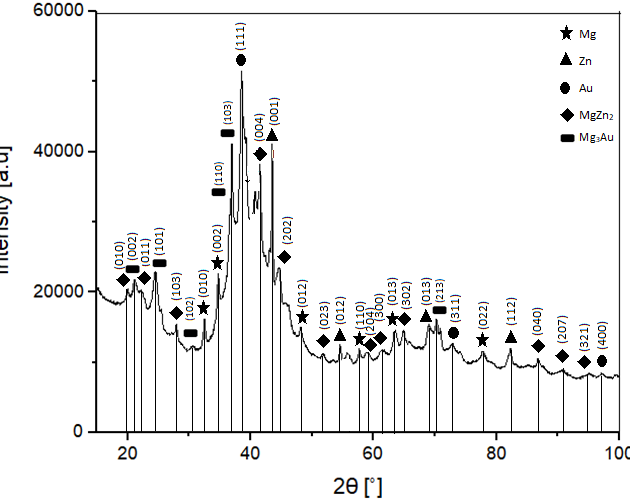
Figure 1 . X-ray diffraction pattern of the Mg–Zn–Ca–Au alloy sample after 13 h milling. Figure 1. X-ray diffraction pattern of the Mg–Zn–Ca–Au alloy sample after 13 h milling.